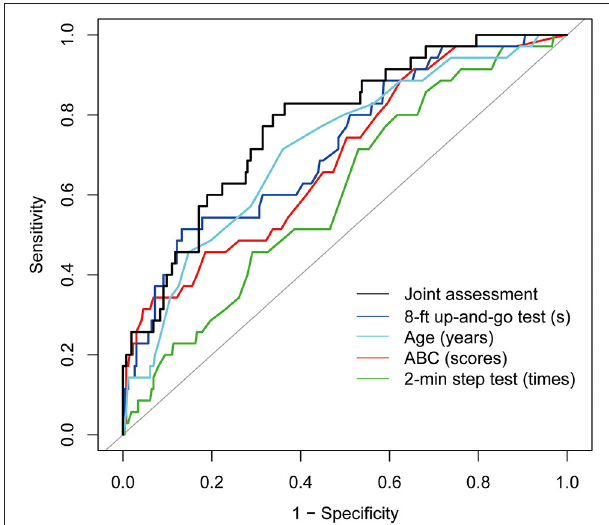
FIGURE 3 | Colored lines represent receiver operating characteristic (ROC) curves of each variable for the prediction of fall events. 8-ft up-and-go test (AUC = 0.728, 95% confidence interval (CI): 0.636–0.820), Age (AUC = 0.718, 95% CI: 0.628–0.808), ABC (AUC = 0.689, 95% CI: 0.595–0.784), 2-min step test (AUC = 0.632, 95% CI: 0.521–0.744). Black line represents ROC curves of LASSO regression with the above four variables for the prediction of fall events. AUC = 0.778, 95% CI: